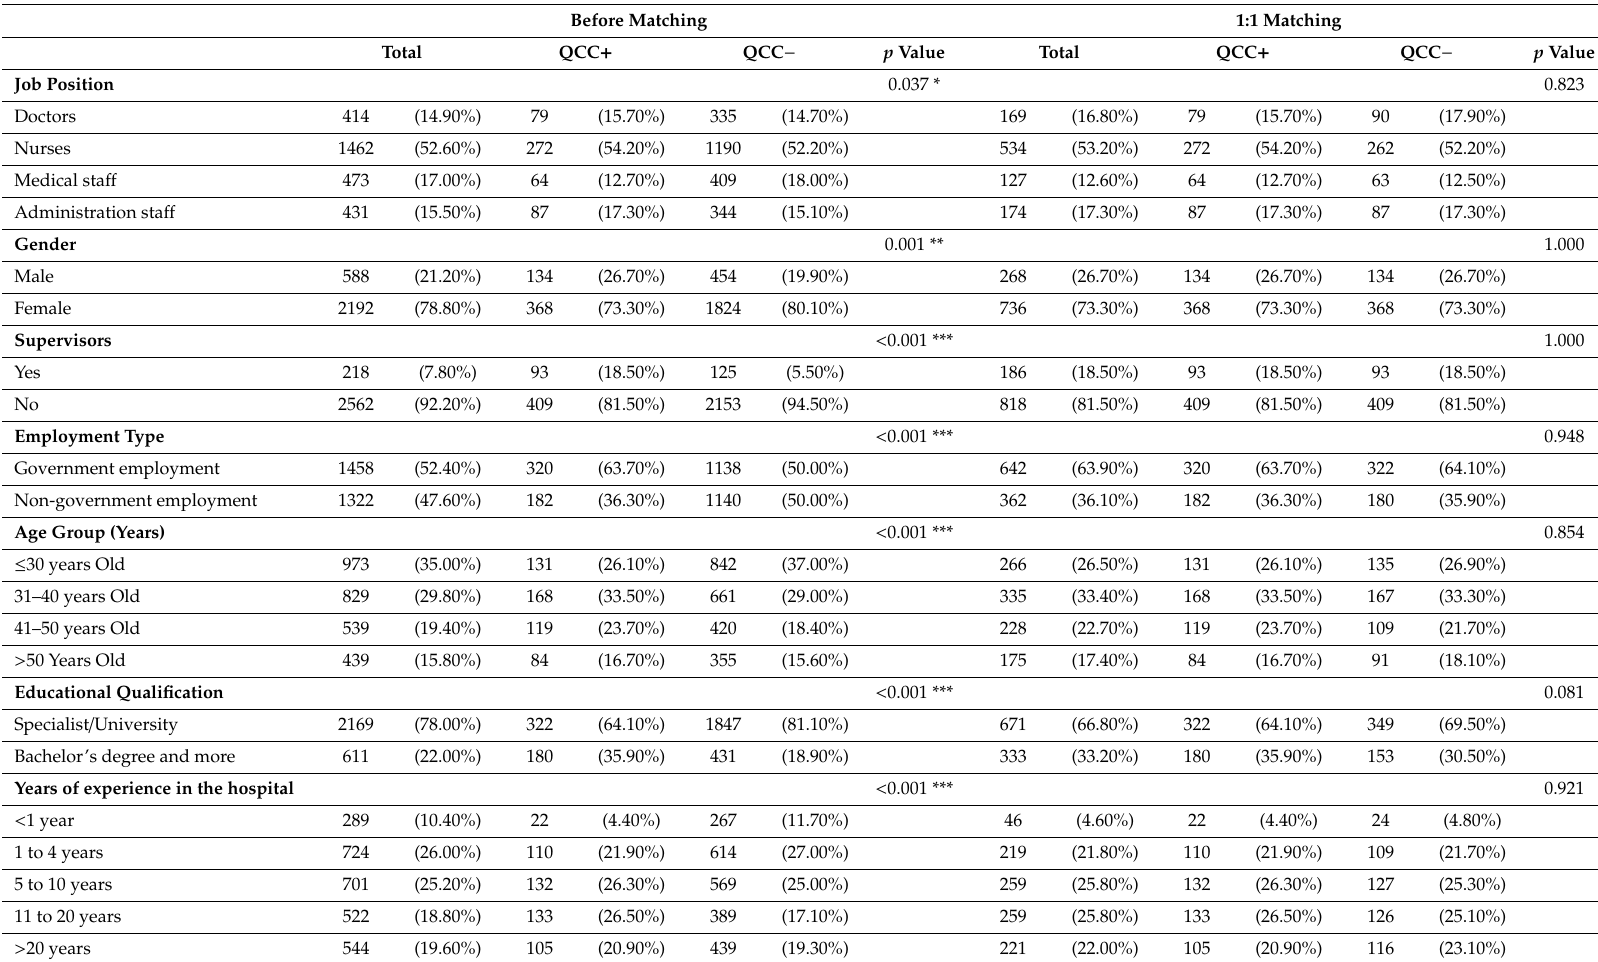
Table 1. Demographic characteristics of participants (before and after 1:1